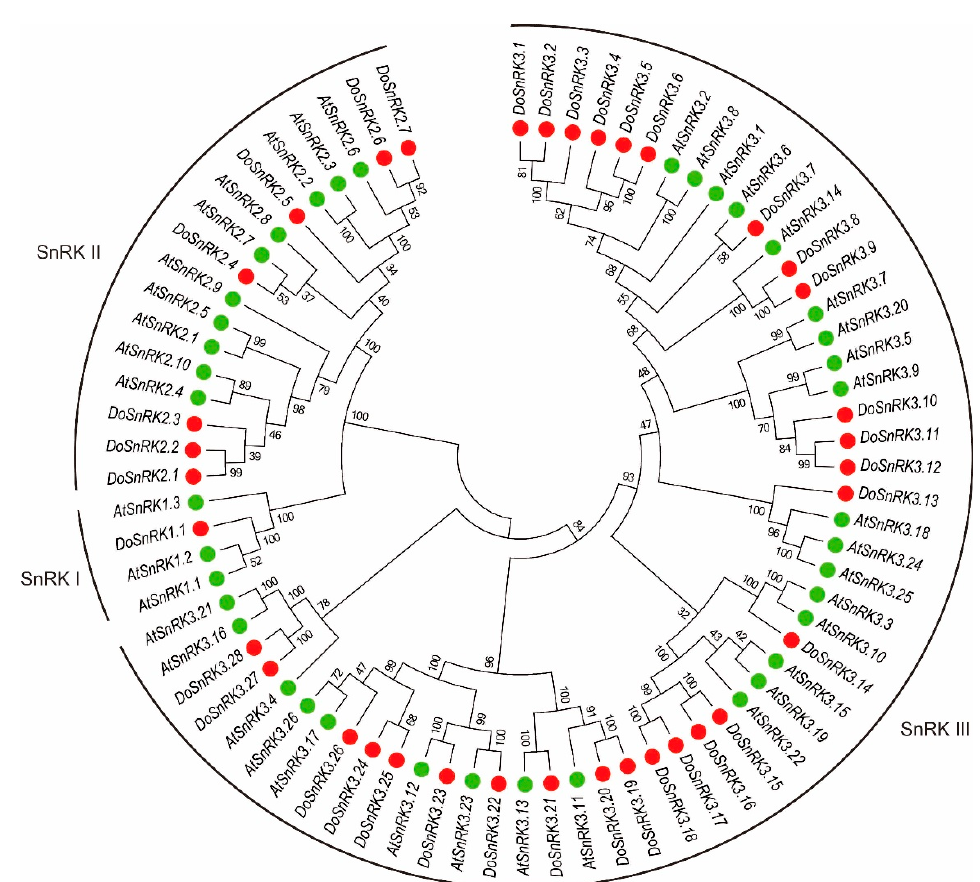
Figure 1. Phylogenetic analysis of sucrose non-fermenting1-related protein kinase (SnRK) proteins from D. officinale and Arabidopsis .